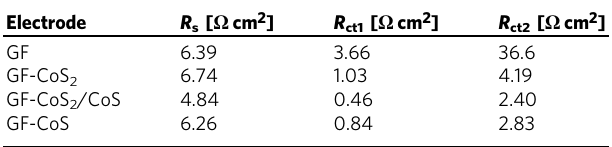
Table 3 Summary of simulation results from EIS spectra of GF, GF-CoS 2 , GF-CoS 2 /CoS, and GF-CoS electrodes,